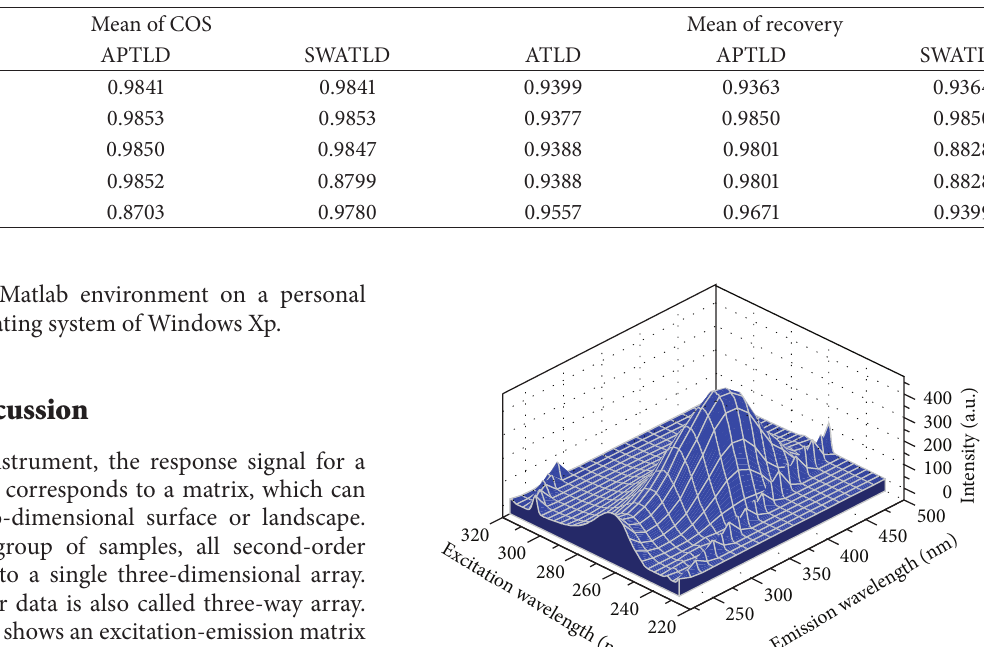
Table 1: Summary of the mean of COS and the mean of recovery related to a different number of factors and algorithms.